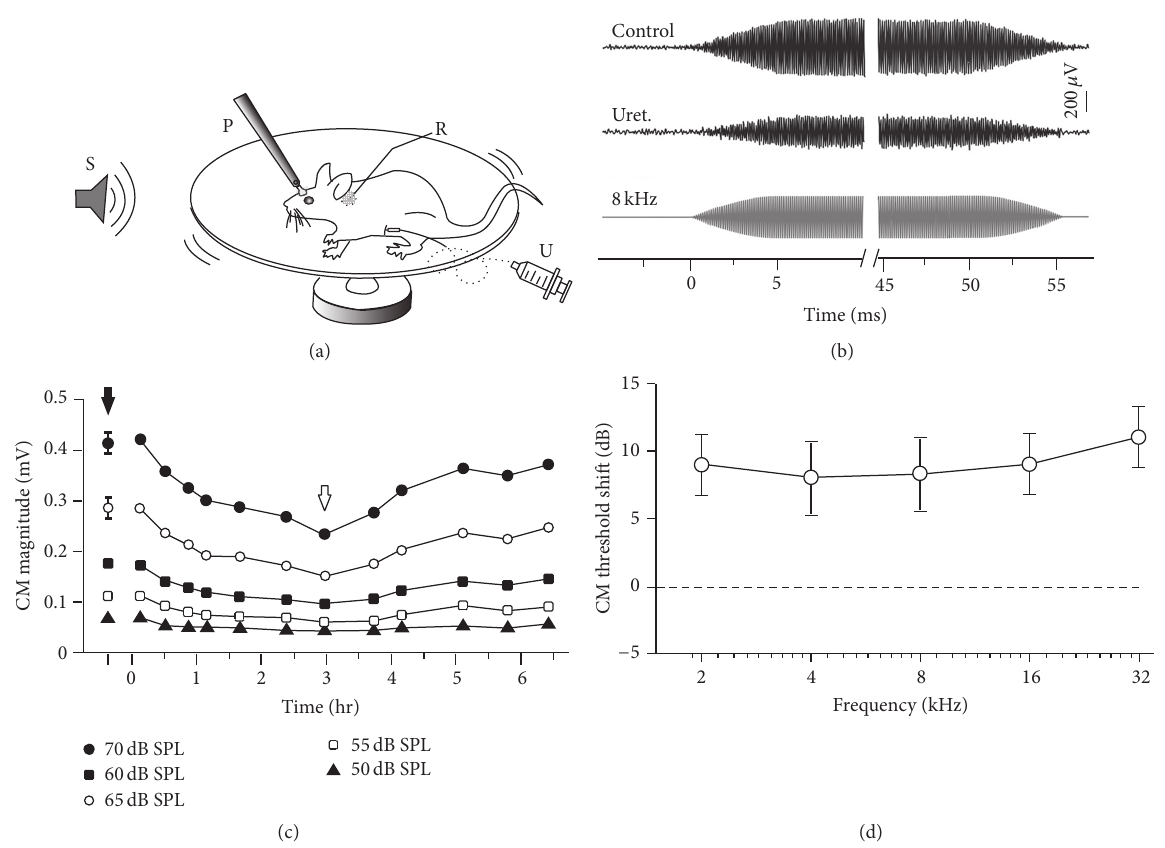
Figure 1: Reduction in the CM after urethane anesthesia. (a) A schematic of our CM recording setup. S, sound stimulation delivered by a speaker; P, metal post for head fixation; R, silver wire recording electrode; U, urethane delivery. The rat was awake and allowed to run freely on a rotatable plate. (b) Examples of the CM measured in response to an 8 kHz, 70 dB SPL tone burst (sound waveform shown in the bottom panel). The magnitude before urethane injection (upper panel, filled arrow in (c)) compared to that after anesthesia (middle panel, open arrow in (c)). (c) The time course of the CM magnitude changes after urethane injection. The curves shown are CM responses to different sound levels. Three CM measurements evoked before urethane injection were averaged as a control (mean ± SD) for each sound level. Time 0 indicates the time point of urethane injection. (d) CM threshold shifts for urethane application. Data presented as mean ± SD. Note the CM thresholds were elevated at all frequencies examined ( 𝑝 < 0.05 , Student’s 𝑡 -test, 𝑛 = 5